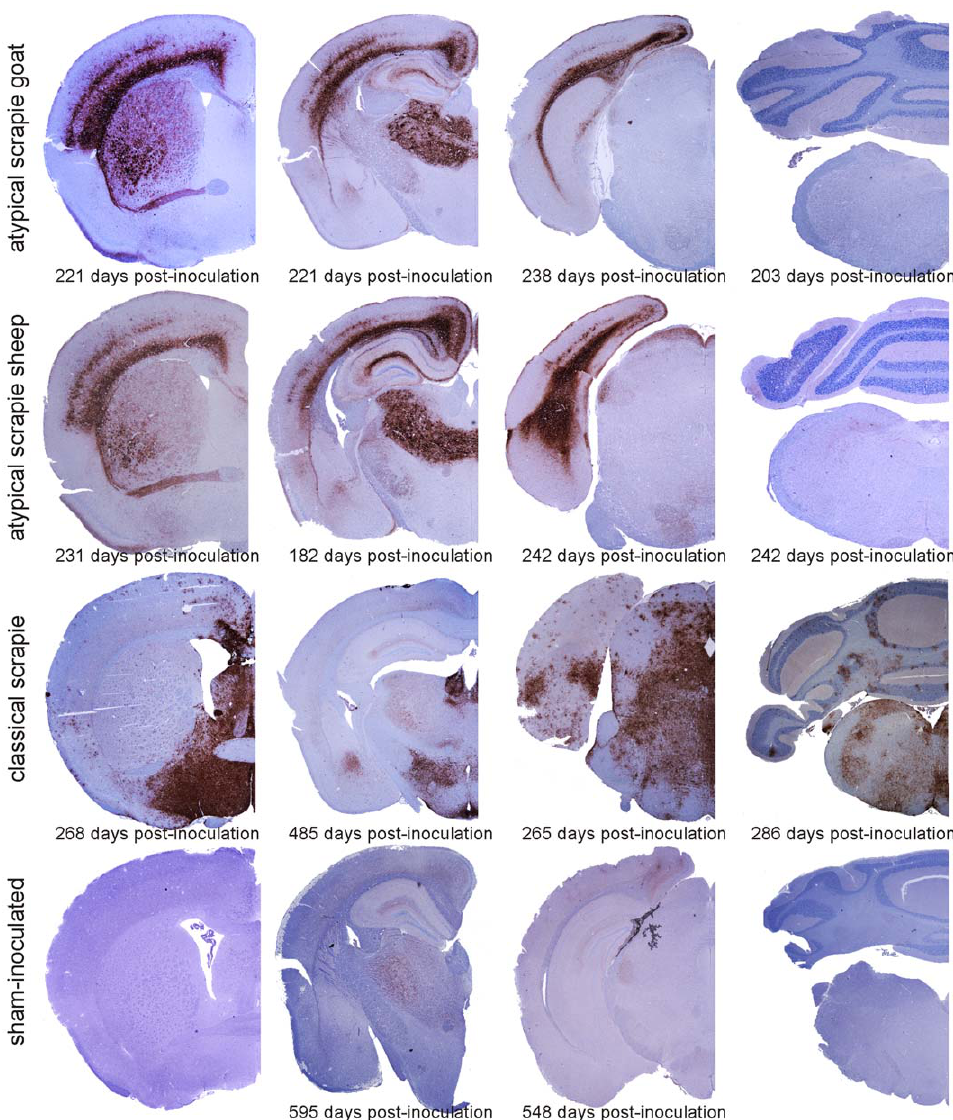
Figure 4. Neuroanatomical PrP d distribution in mice inoculated with different scrapie isolates. Microphotographs of representative mouse brain sections stained for PrP d by immunohistochemistry using antibody SAF84 are presented. For details on the anatomical structures, see Fig S1 .